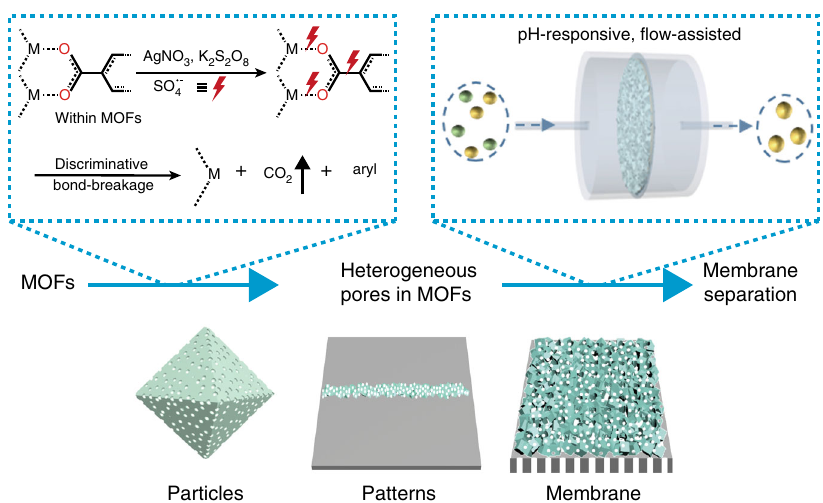
Fig. 1 Heterogeneous MOFs via decarboxylation process. The process can be applied to obtain heterogeneous pores in different forms of MOFs such as particles, patterns, and